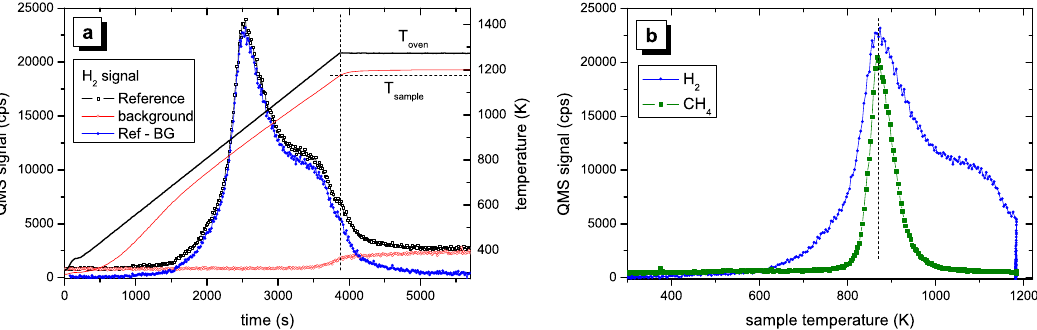
Figure 2. Hydrogen release during a normal TPD run with a nominal temperature ramp of 15 K/min: ( a ) plotted are the QMS raw signal (left-hand scale) for 2 amu (black open squares), the background signal on 2 amu for an empty oven (red open circles), and the background subtracted data (blue solid circles) as a function of time. In addition, the oven and sample temperatures are shown on the right-hand scale (solid lines). The dashed vertical line indicates the end of the oven temperature ramp and the dashed horizontal line the sample temperature in that moment. The steady-state sample temperature is reached after about 5 min. In ( b ) the background subtracted data for 2 amu and the raw data for 16 amu (CH 4 ) are shown as a function of sample temperature (background for the 16 amu signal is